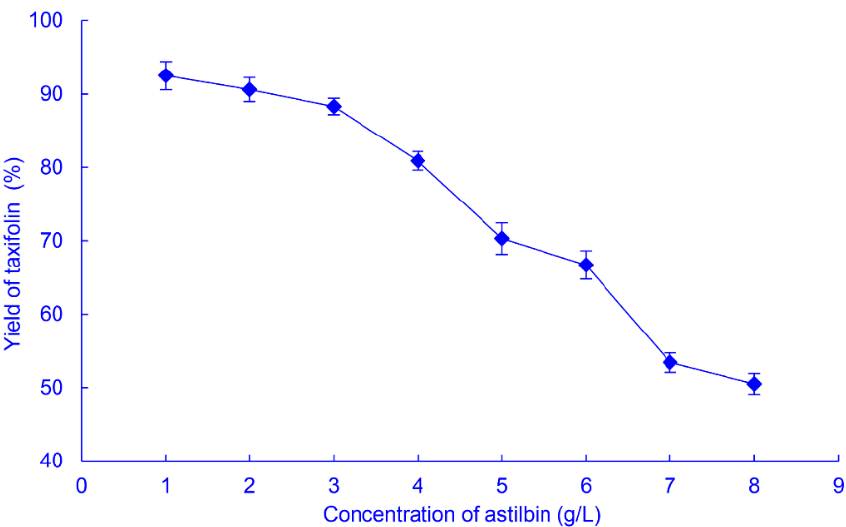
Figure 5. The yield of taxifolin from biotransformation of astilbin at different concentrations by A. fumigatus SQH4. Biotransformation was performed at 35 °C, pH 6.5, with shaking at 200 r/min for 8 h.